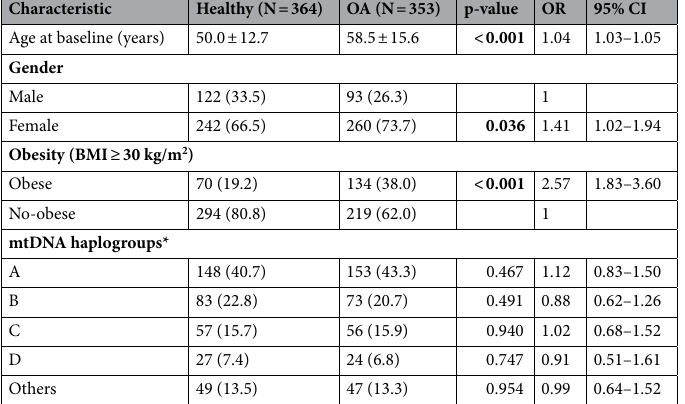
Table 2. Univariate analysis of risk factors affecting knee osteoarthritis (KL grade ≥ I). Values are mean ± standard deviation or number of patients with percentage in parentheses. BMI body mass index, KL Kellgren and Lawrence. *Statistical parameters after comparing the presence of each haplogroup versus its absence; significant p-values are in bold.